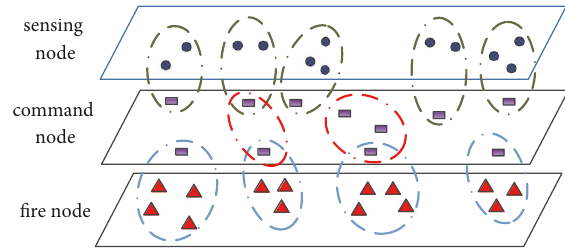
Figure 1: Command and control hypernetwork